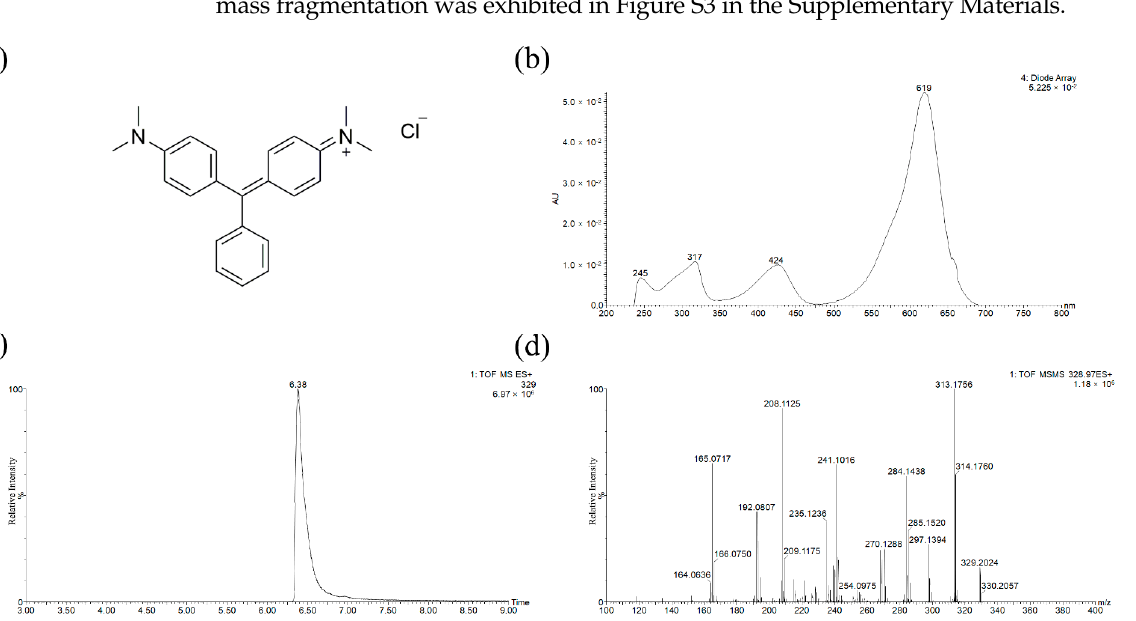
Figure 5. MG chromatogram and spectra: ( a ) molecular structure; ( b ) UV–visible absorption spec- trum; ( c ) extracted ion chromatogram (EIC); and ( d ) MSMS spectrum with pseudo-molecular ion m/z 329 in a positive ion mode.